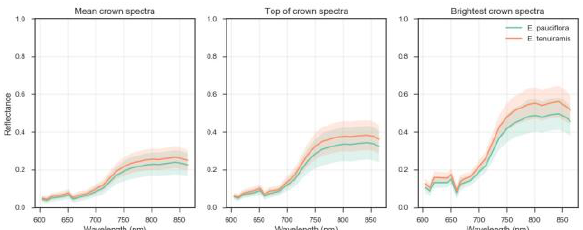
Figure 4. The hyperspectral point cloud based mean and for both E. pauciflora and E. tenuiramis